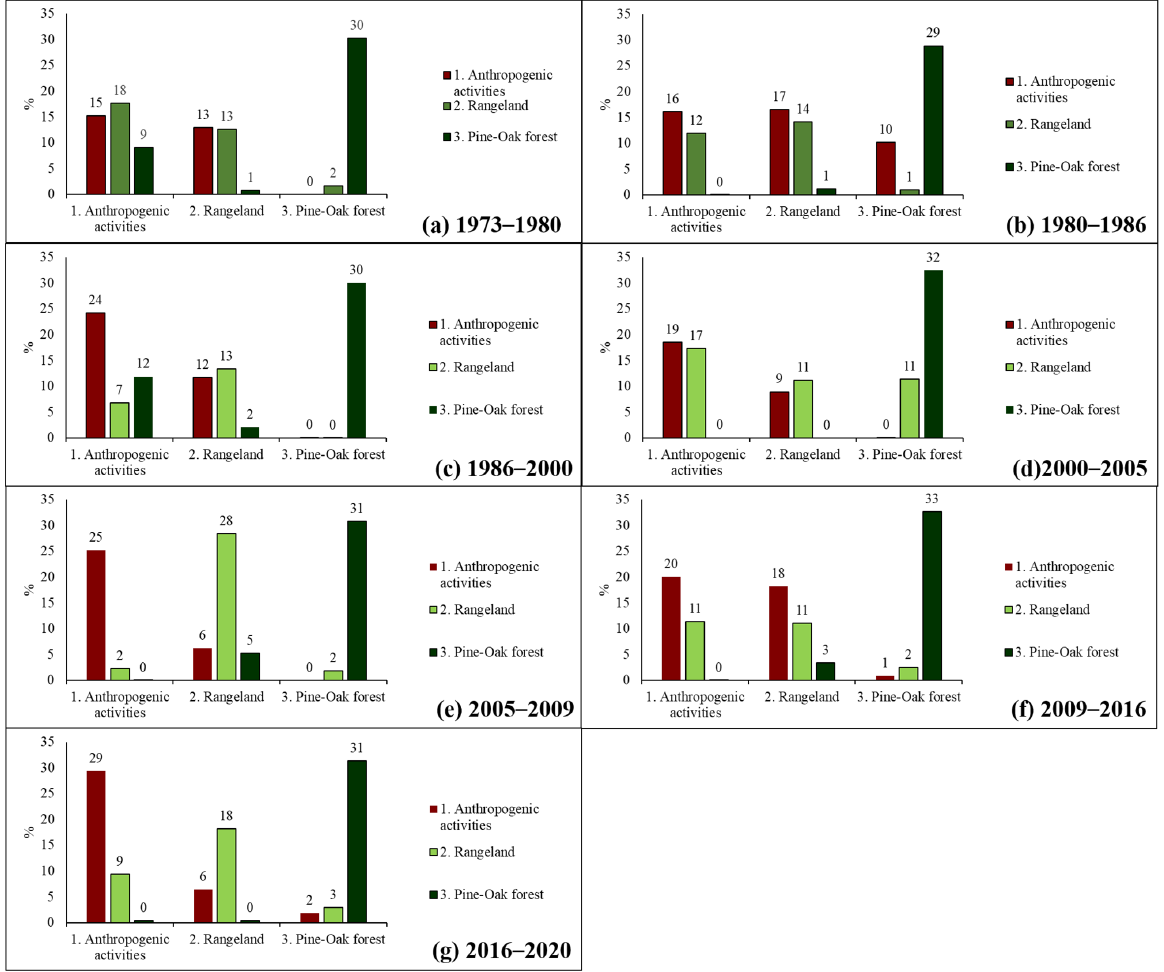
Figure 12. Percentage of changes in land cover in the scenarios of ( a ) 1973–1980, ( b ) 1980–1986, ( c ) 1986–2000, ( d ) 2000–2005, ( e ) 2005–2009, ( f ) 2009–2016, and ( g ) 2016–2020, La Peña, Miquihuana, Tamaulipas, Mexico.